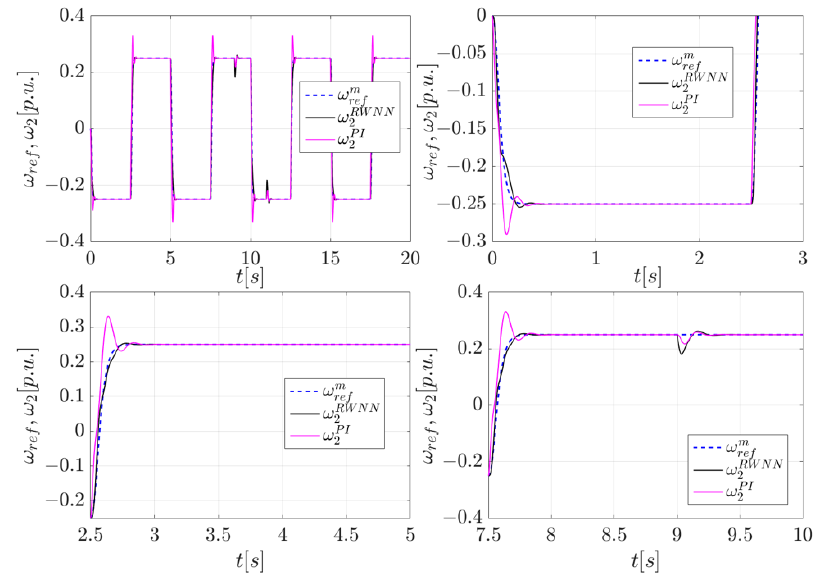
Figure 12. Results for RWNN controller and PI controller with increased load time constant— T 2 n = 2 T 2 n .